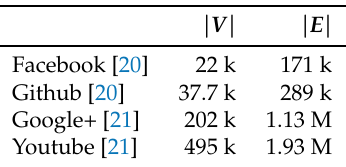
Table 1. Datasets used in numerical experiments. Only the largest connected component has been kept in case of a disconnected graph.